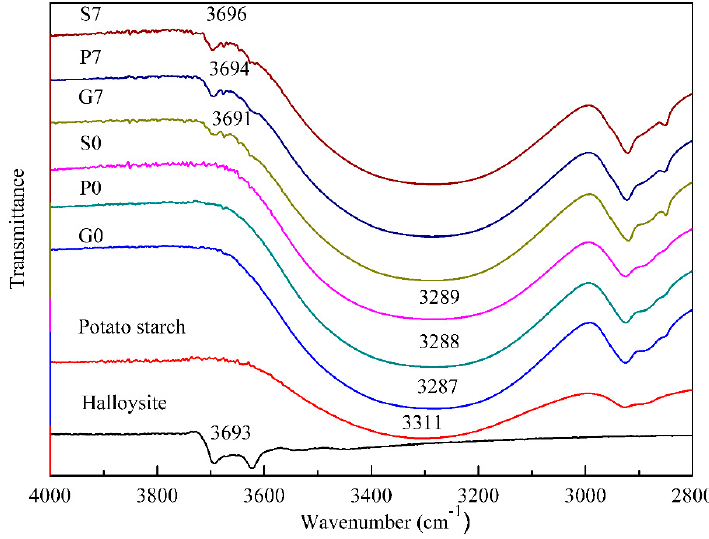
Figure 2. ATR-FTIR spectra of the native potato starch, halloysite nanoclay, unfilled plasticized starch matrices (G0, S0, P0) and plasticized starch nano-biocomposites containing 7 wt.% halloysite nanoclay (G7, S7, P7).